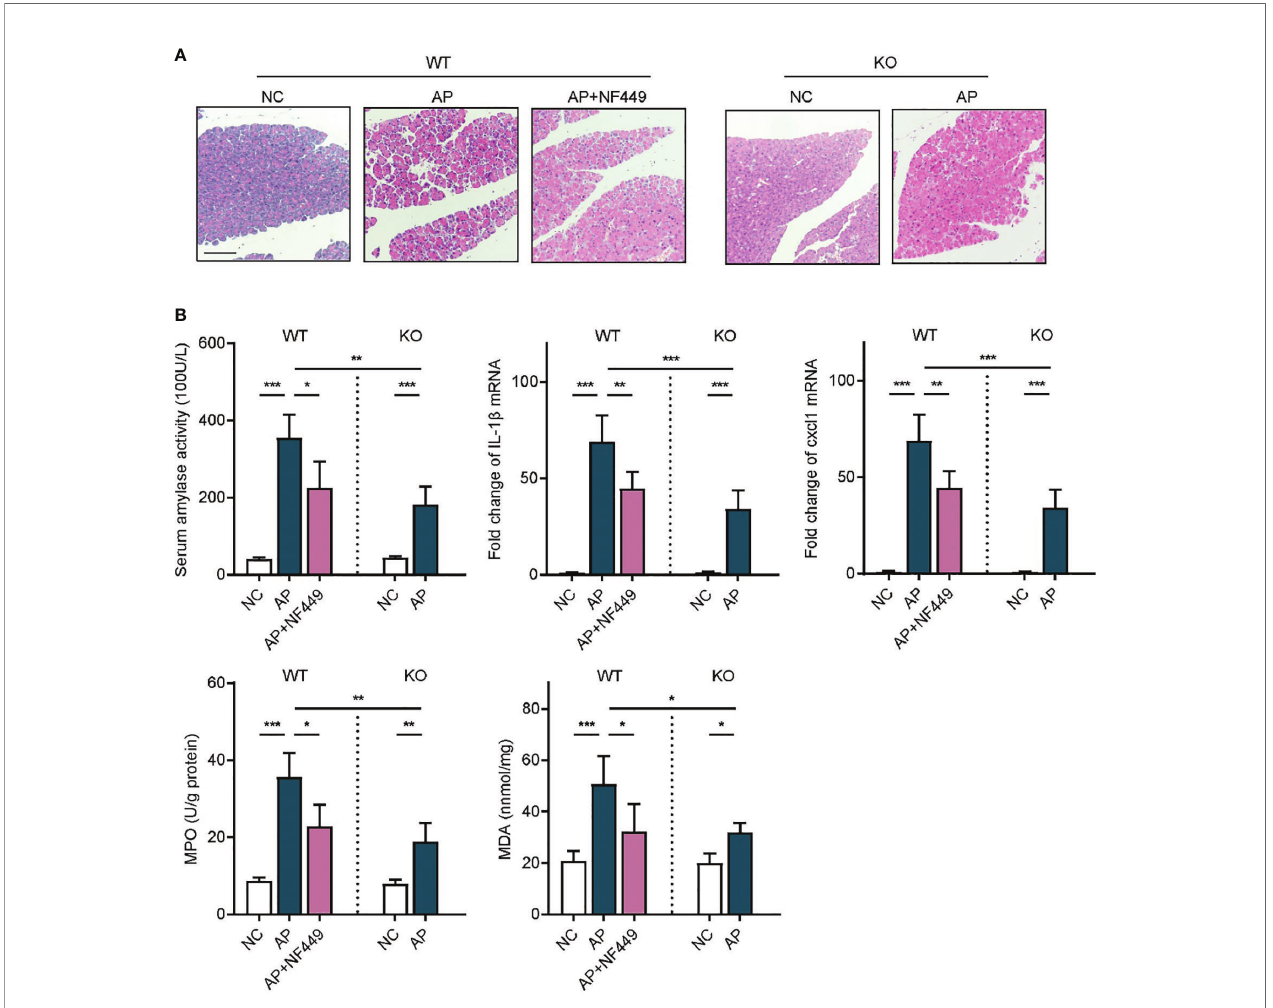
FIGURE 3 | Targeting purinergic receptor P2RX1 alleviated in fl ammatory responses in acute pancreatitis. (A) Caerulein (50 m g/kg) was intraperitoneally injected seven times hourly to induce acute pancreatitis in WT and P2RX1-KO mice. NF449 or vehicle was intraperitoneally injected immediately after the fi rst injection of caerulein. Saline-treated mice were set as negative control (NC). Pancreas tissues from each group were harvested at 8 h, stained with H&E, and observed under a microscope (100×). Representative images were shown. Scale bar is 50 m m. (B) At 8 h after caerulein exposure, serum amylase activity, pancreas IL1- b mRNA expression, Cxcl1 mRNA expression, myeloperoxidase (MPO) activity, and malondialdehyde (MDA) were analyzed to evaluate in fl ammatory status (n = 5 per group). 2 − dd Ct value was used for comparisons of the fold change of mRNA expression to NC mice. Statistics were calculated using one-way ANOVA with Tukey post-tests. * P < 0.05, ** P < 0.01, *** P <